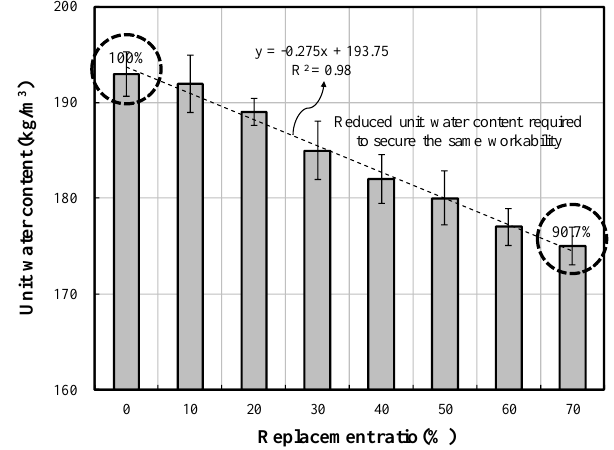
Figure 6. Result of unit water content with respect to replacement ratio.